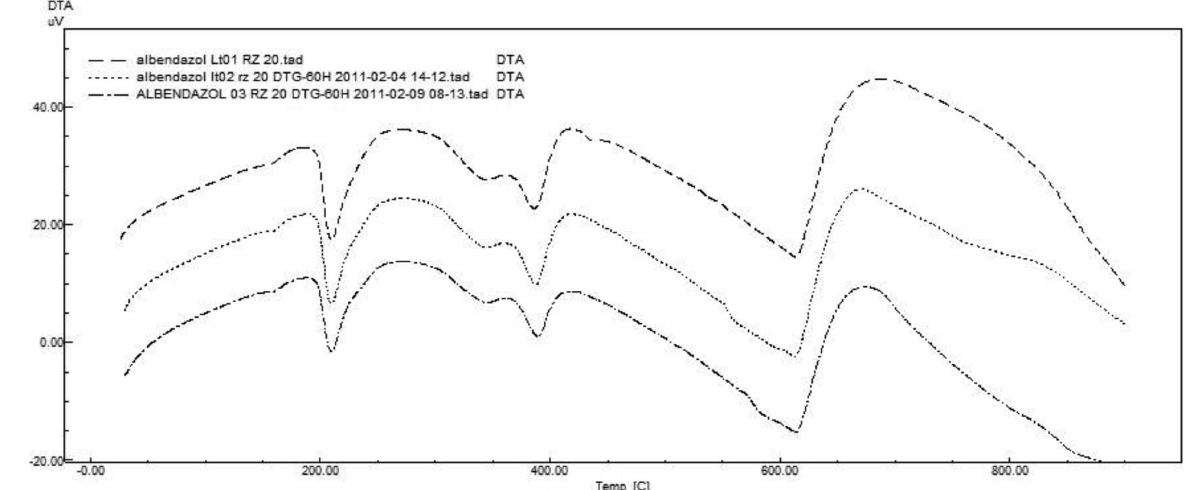
FIGURE 7 - Thermal profile of the 3 batches ABZ01, ABZ02, ABZ03 based on DTA curves.